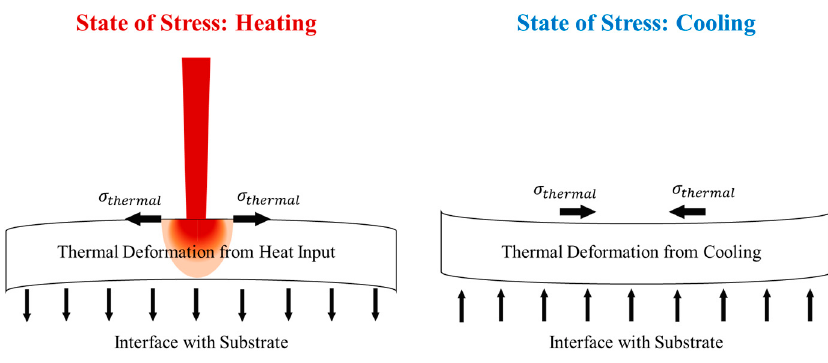
Figure 2. Stress gradients in single layers.